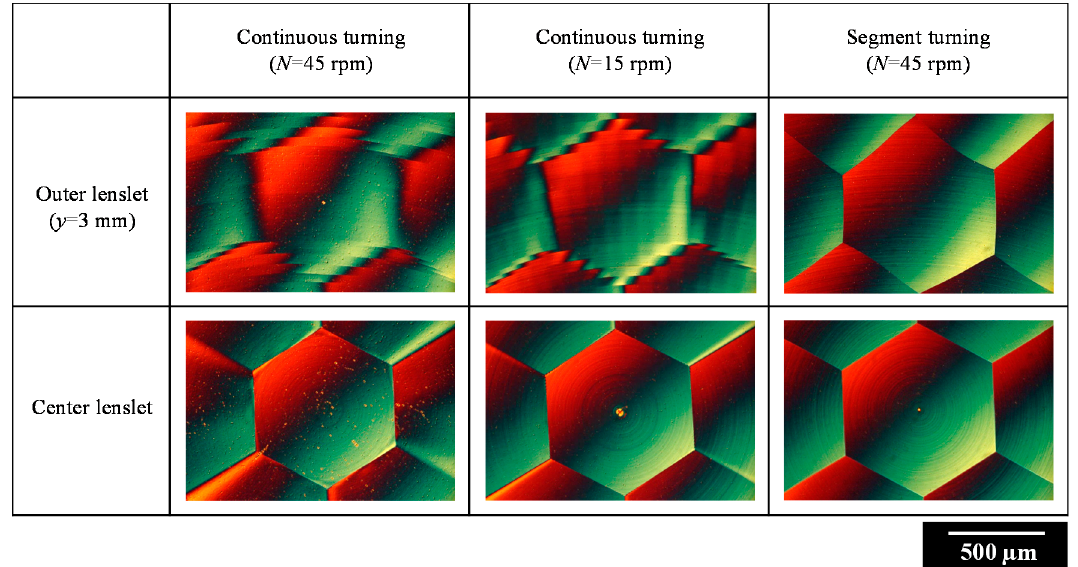
Figure 6. Differential interference contrast microscope images of lenslets machined by continuous turning at different spindle rotation rates, as well as by segment turning.